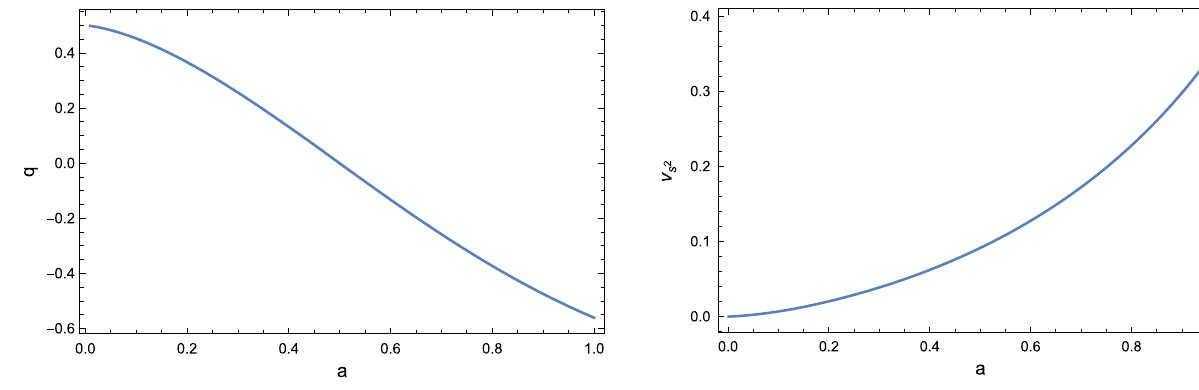
Fig. 7 Variation of Deceleration parameter with a Fig. 8 Variation of speed of sound with